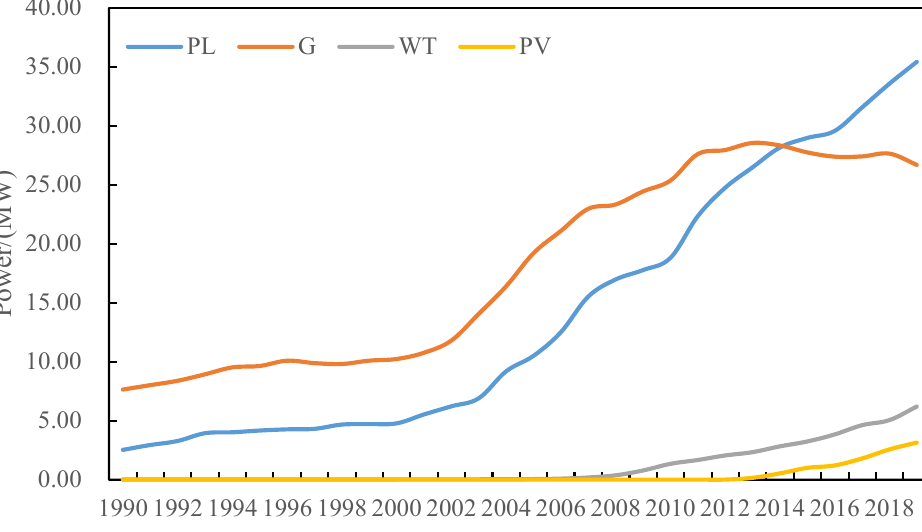
Figure 4. Model input historical data.